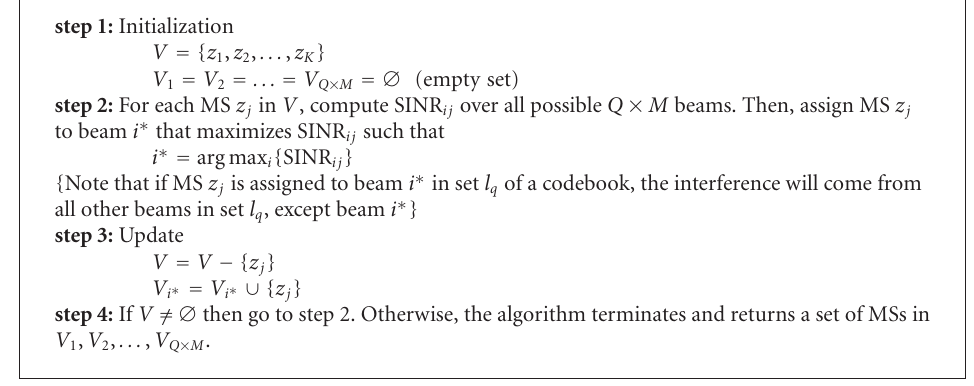
Algorithm 2: Codebook-based allocation algorithm.